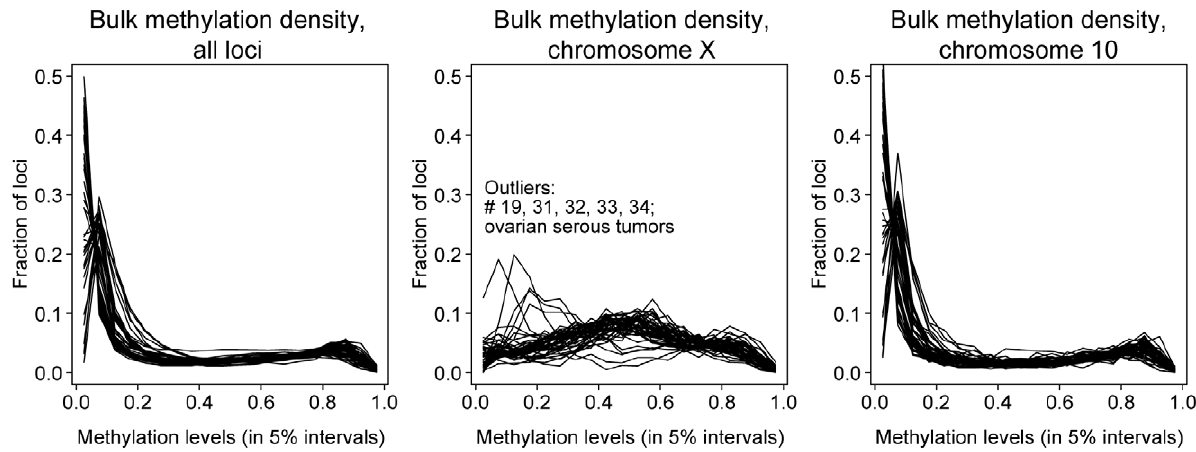
Figure 1. Bulk methylation levels across genomic loci. Frequency of methylation at all loci for a given level of methylation (range 0 to 1). Each biological sample is represented as a single line; all non-metastatic samples were plotted. Respectively, panels from left to right contain all loci (N=27,561), X chromosome only (N=1038), or chromosome 10 only (N=1044).